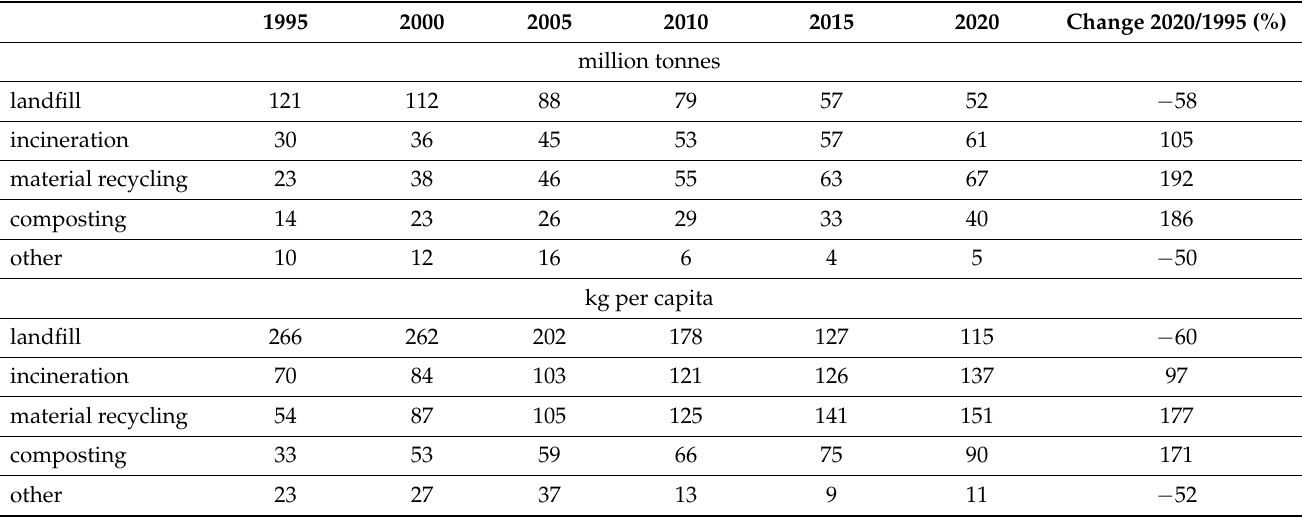
Table 3. Municipal waste landfilled, incinerated and composted in European countries in